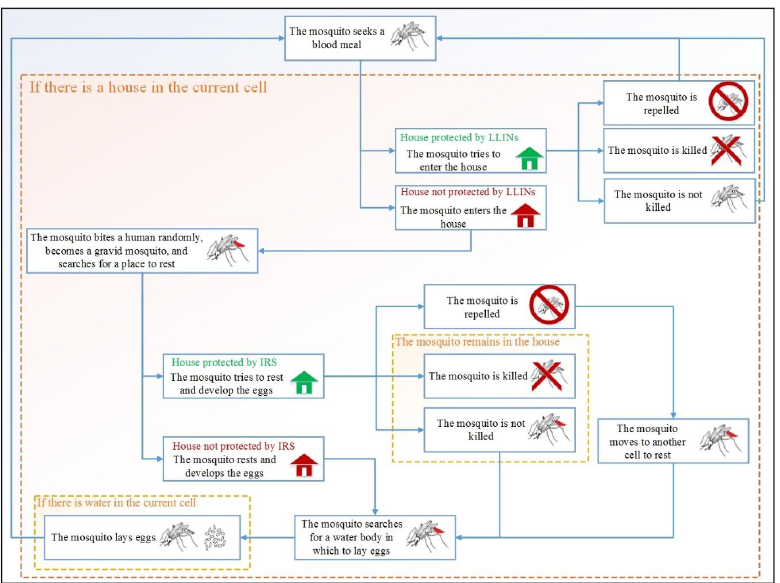
Figure 6. Flowchart of applying LLINs and IRS in combination.